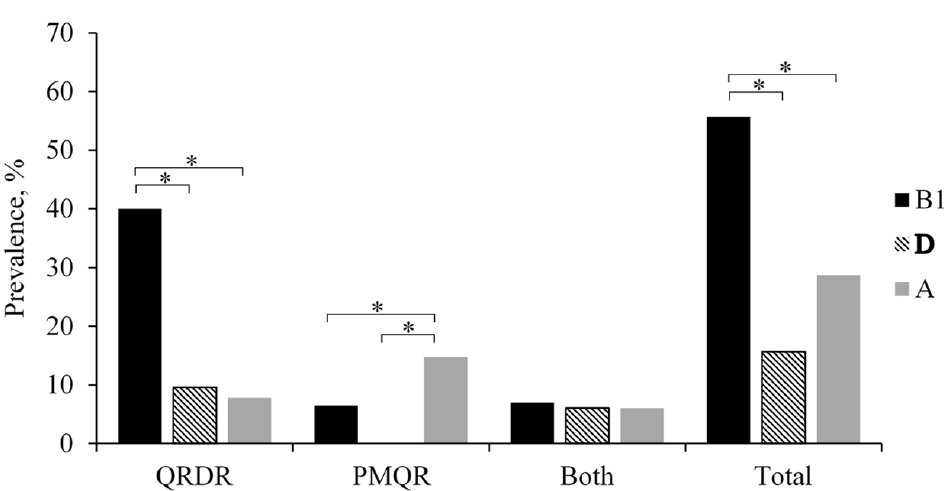
Figure 3. Prevalence of phylogenetic groups in 115 isolates not susceptible to quinolones but harboring mutations in QRDR and/or PMQR genes, from food-producing animals and their food products, collected in the Philippines. * The p -value was significant ( p < 0.05).